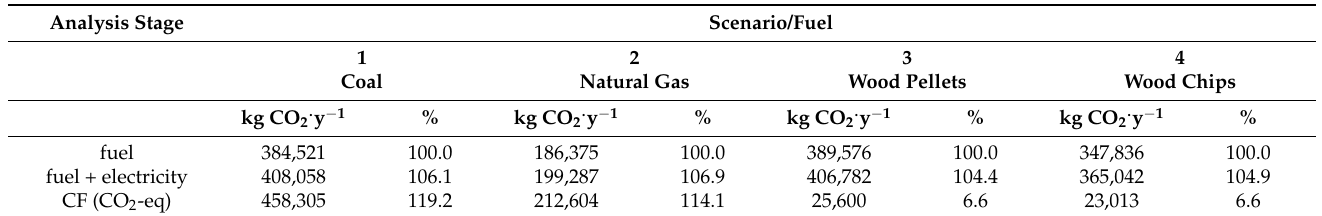
Table 7. Annual emissions of carbon dioxide and CF—comparison of the analysis